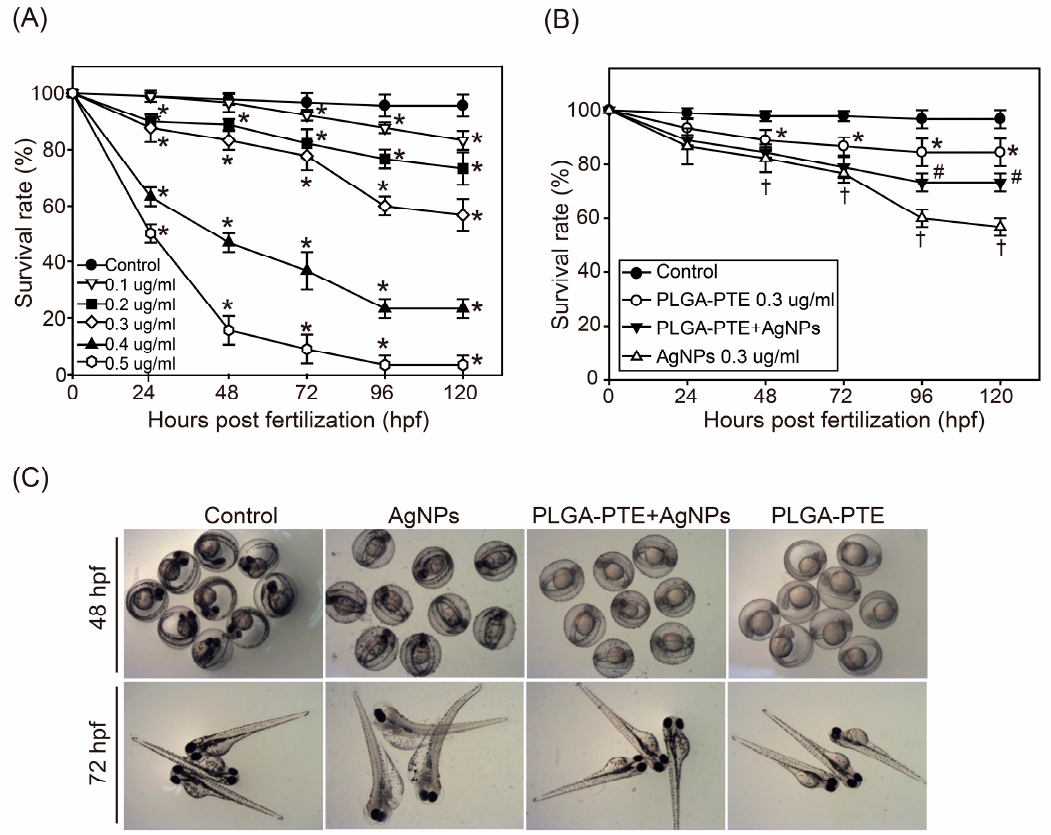
Figure 3. The survival rate of zebrafish embryos. The survival rate of zebrafish embryos exposed to ( A ) AgNPs (0, 0.1, 0.2, 0.3, 0.4, 0.5 µ g/mL) for 0, 24, 48, 72, 96, and 120 h post fertilization (hpf) ( n = 30). The data are presented as the mean ± standard deviation of three independent experiments. ( B ) Survival rate of zebrafish embryos exposed to control, 0.3 µ g/mL PLGA-PTE, PLGA-PTE + AgNPs (0.3 µ g/mL PLGA-PTE pretreated for 1 h then changed to 0.3 µ g/mL AgNPs), or 0.3 µ g/mL AgNPs for the indicated time points ( n = 30). In every treated group, the exposure solutions were replaced every day. The data are presented from at least three independent experiments. * p < 0.05, PLGA-PTE versus control groups; # p < 0.05, PLGA-PTE + AgNPs versus AgNPs groups; † p < 0.05, AgNPs groups versus control groups. ( C ) Appearance of the zebrafish embryos after exposure to control, 0.3 µ g/mL AgNPs, PLGA-PTE + AgNPs, and 0.3 µ g/mL PLGA-PTE for 48 and 72 hpf under the microscope.